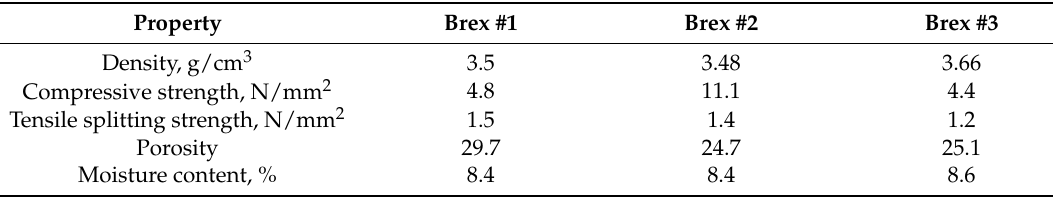
Table 4. Physical–mechanical properties of raw brex.